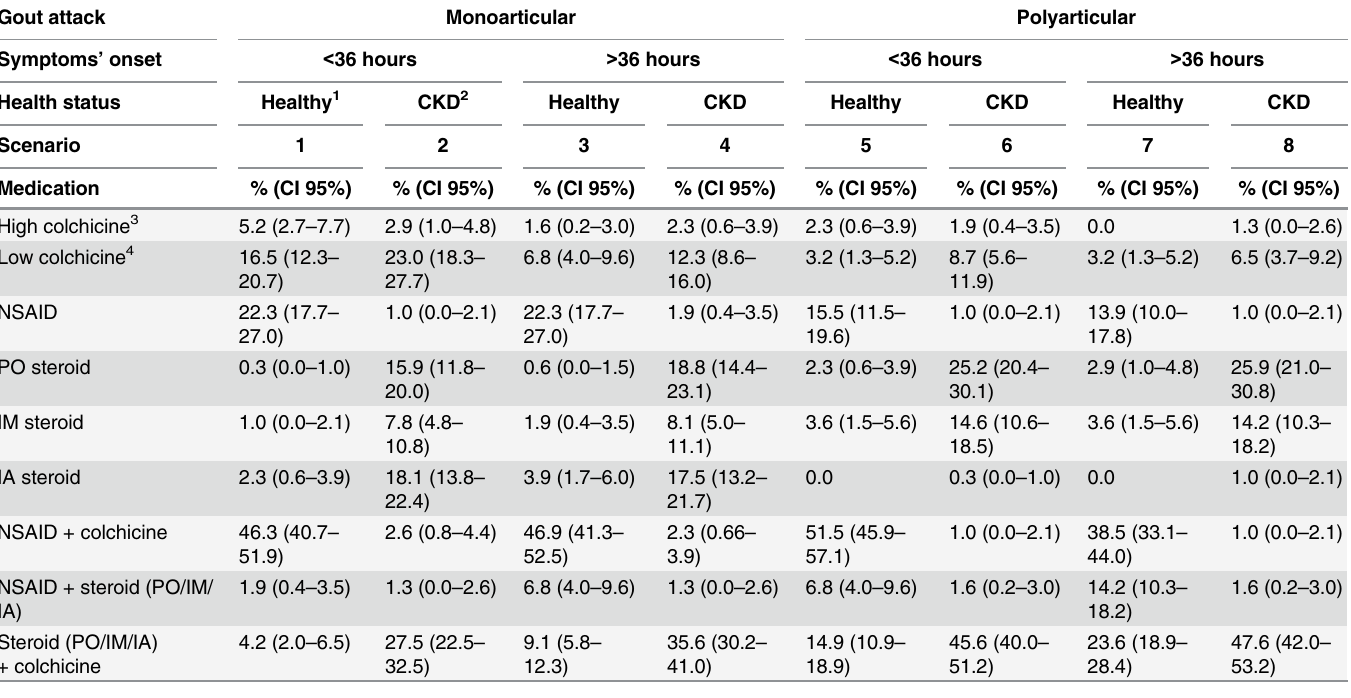
Table 2. Acute gout management: first choice drug(s) to treat an acute gouty attack in different scenarios (N = 309). Gout attack